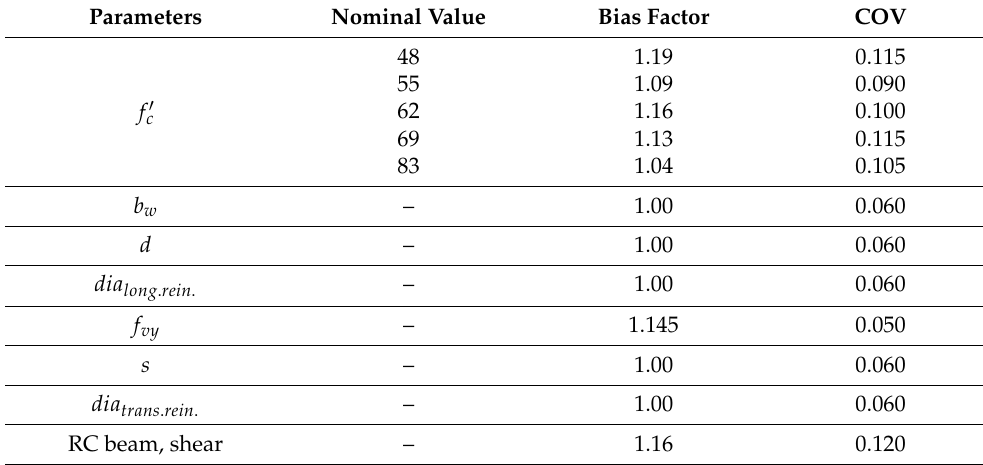
Table 3. Statistical parameter for variables